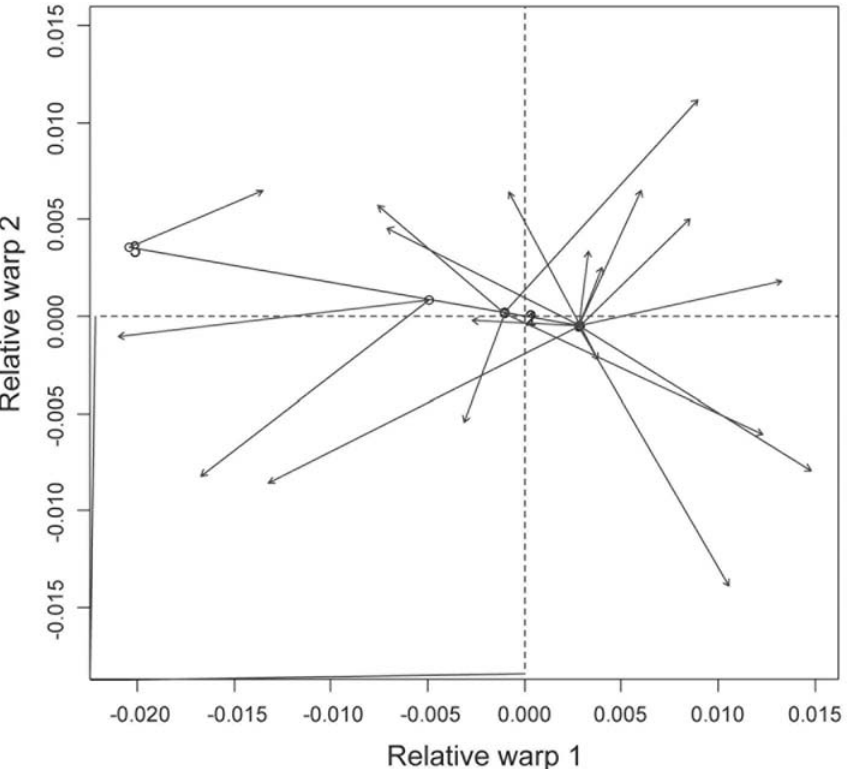
Figure 4. Procrustes fit of geographic coordinates and temporal data (circle) onto the position of mean facial shape for each East Central Argentina sample on relative warps 1 and 2.